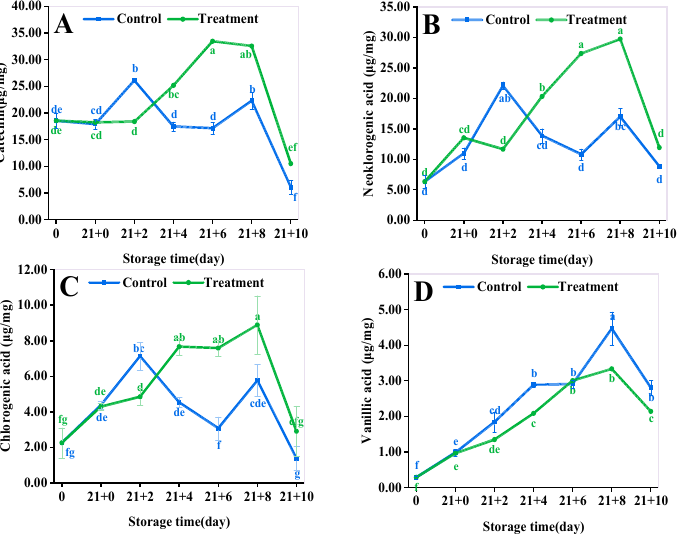
Figure 5. Different storage methods on yellow peach catechin ( A ), neochlorogenic acid ( B ), chlorogenic acid ( C ), and vanillic acid ( D ). Vertical bars represent standard deviations. Different letters represent statistical differences ( p < 0.05).